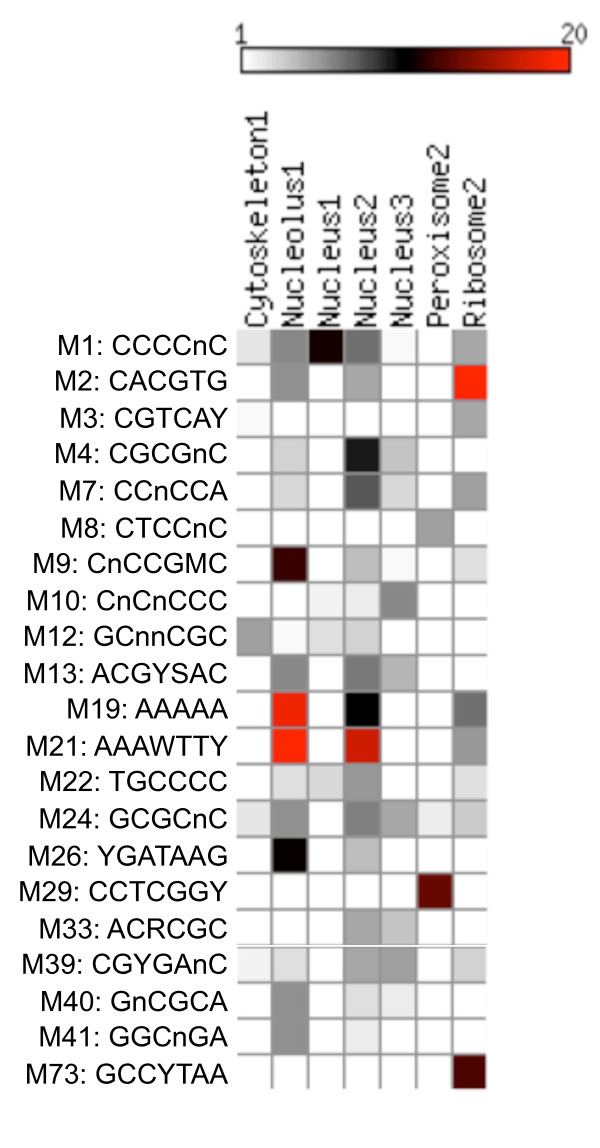
Enrichment of promoter motifs in functional gene clusters. Many of the discovered motifs are enriched in the upstream regions of genes grouped on the basis of GO annotation and expression profiles. This enrichment is quantified by a P-value derived using hyper-geometric distribution (see methods). The pseudo-colors in the cells represent -log10 (Hypergeometric P-value). The figure shows the cluster and the motif with the highest enrichment within that cluster. Only those clusters with a minimum enrichment score of 5.0 are shown. The columns represent the gene sets derived using GO annotation and clustering with the expression data within each GO category.